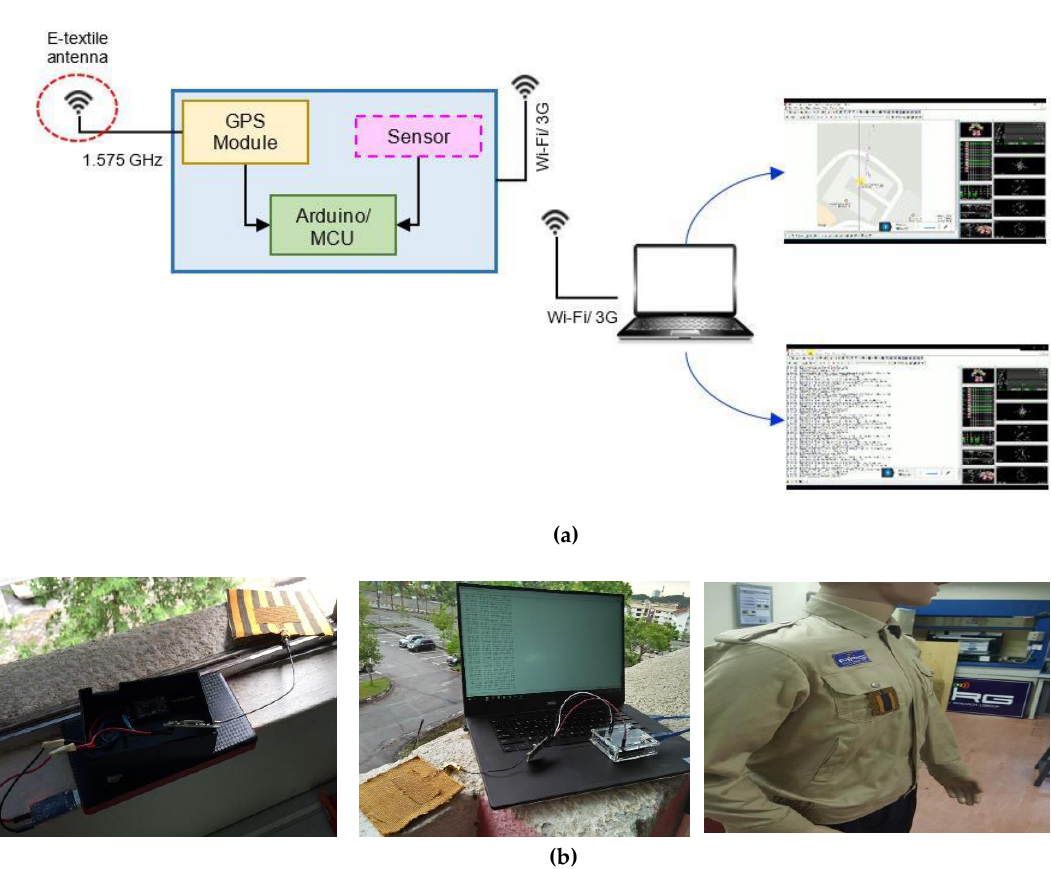
Figure 18. ( a ) Block diagram of GPS tracking system test bench; ( b ) Measurement setup of the integration of e-textile antenna with GPS tracking module. During operation, precise and consistent real time GPS data (location) were received at the server (computer) without any losses or intermittence.